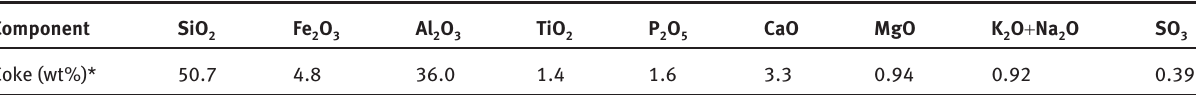
Table 3: Ash analysis of